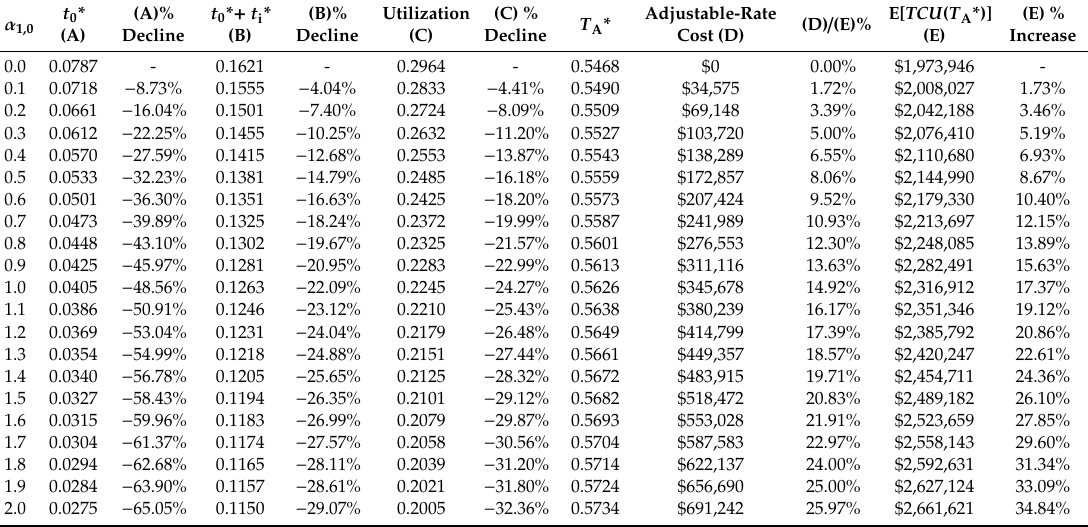
Table A2. The impact of variations in α 1,0 on diverse system-relevant